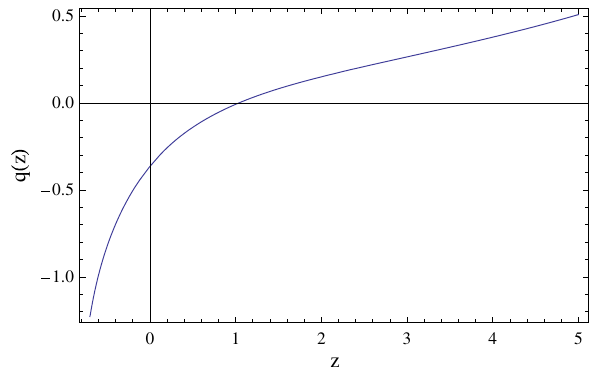
Fig. 19 Variation of q ( z ) with the variation of z (Model III) by con- sidering the best fit values w 0 = − 0 . 754 ,w 1 = 0 . 261